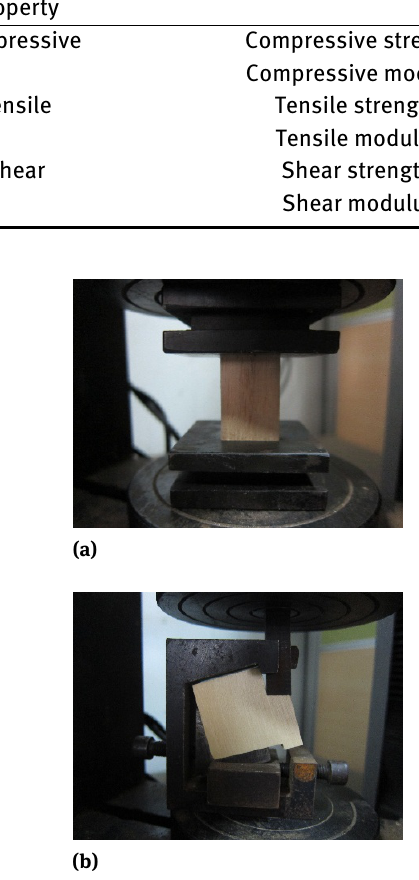
Figure 5: Test set-up of wood material: (a) compressive test (b) shear test.